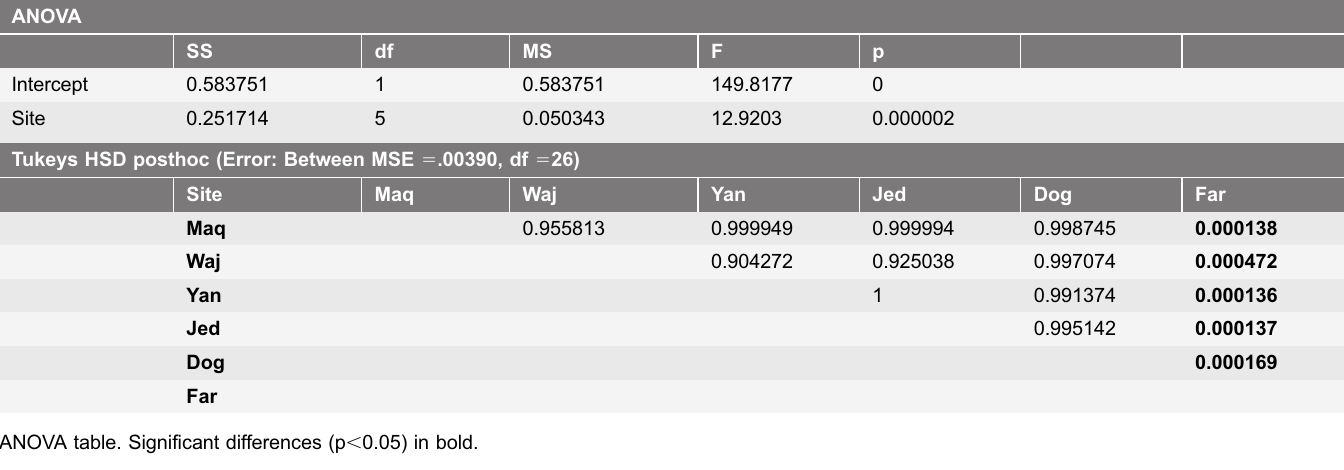
Table 3. Comparison of microfouling pressure among